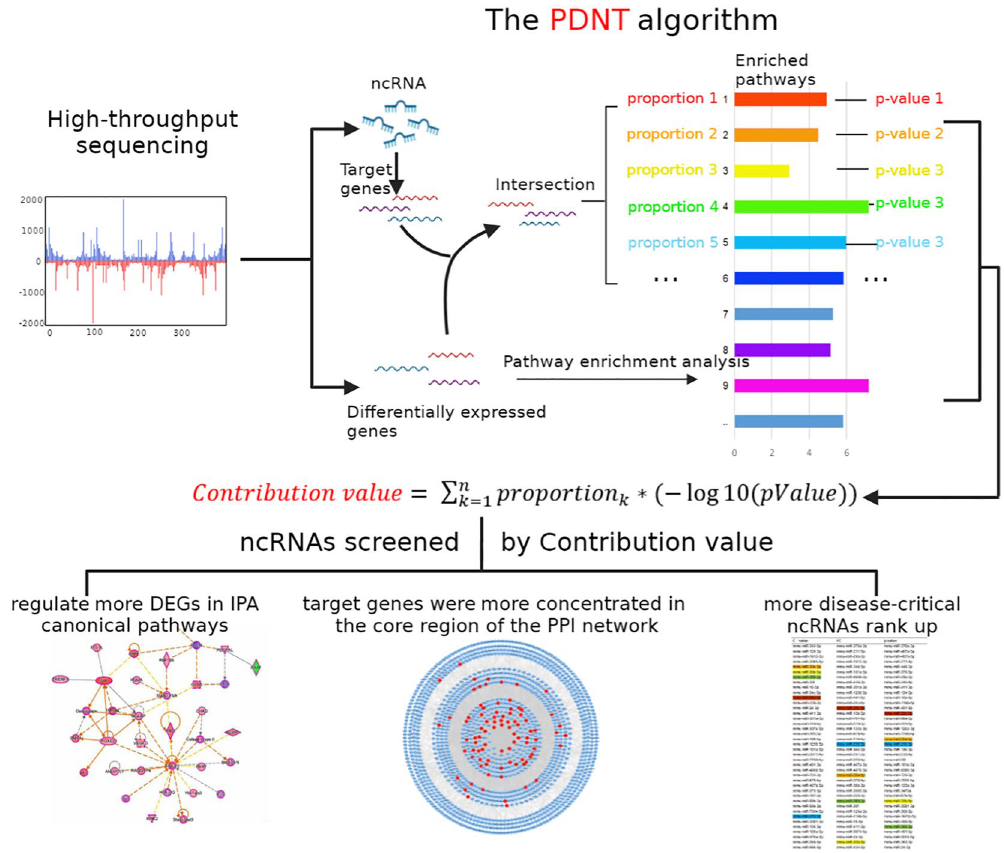
Figure 7. The operation and verification process of the PDNT algorithm.